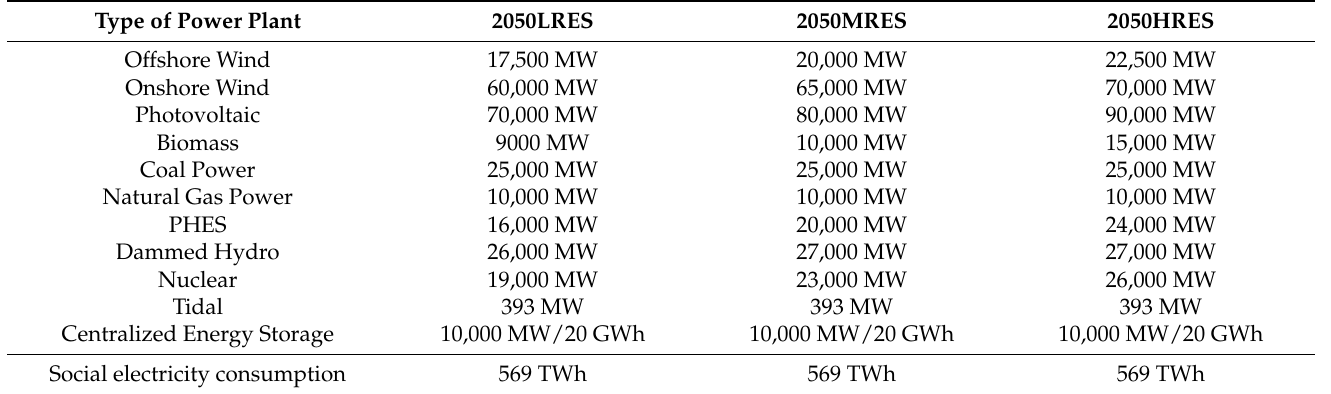
Table 7. The future installed capacity of power generation technologies for Guangxi in the 2050